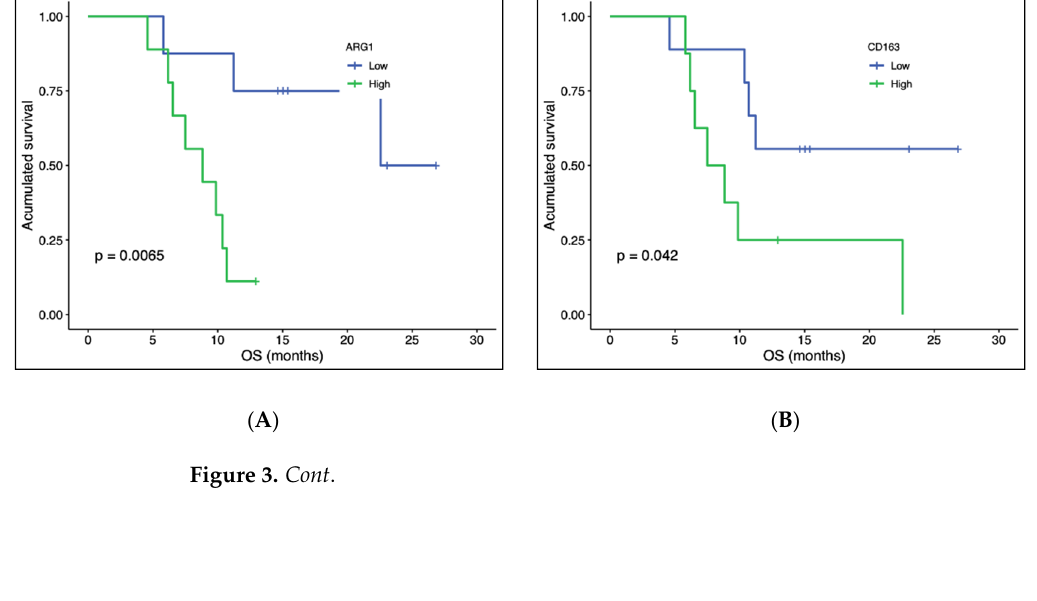
( F ) Figure 3. Kaplan–Meier overall survival analysis by baseline gene expression (only statistically sig- nificant genes are represented). ( A ) ARG1. ( B ) CD163. ( C ) IL1R2. ( D ) S100A12. ( E ) SLC11A1. ( F ) MERTK.